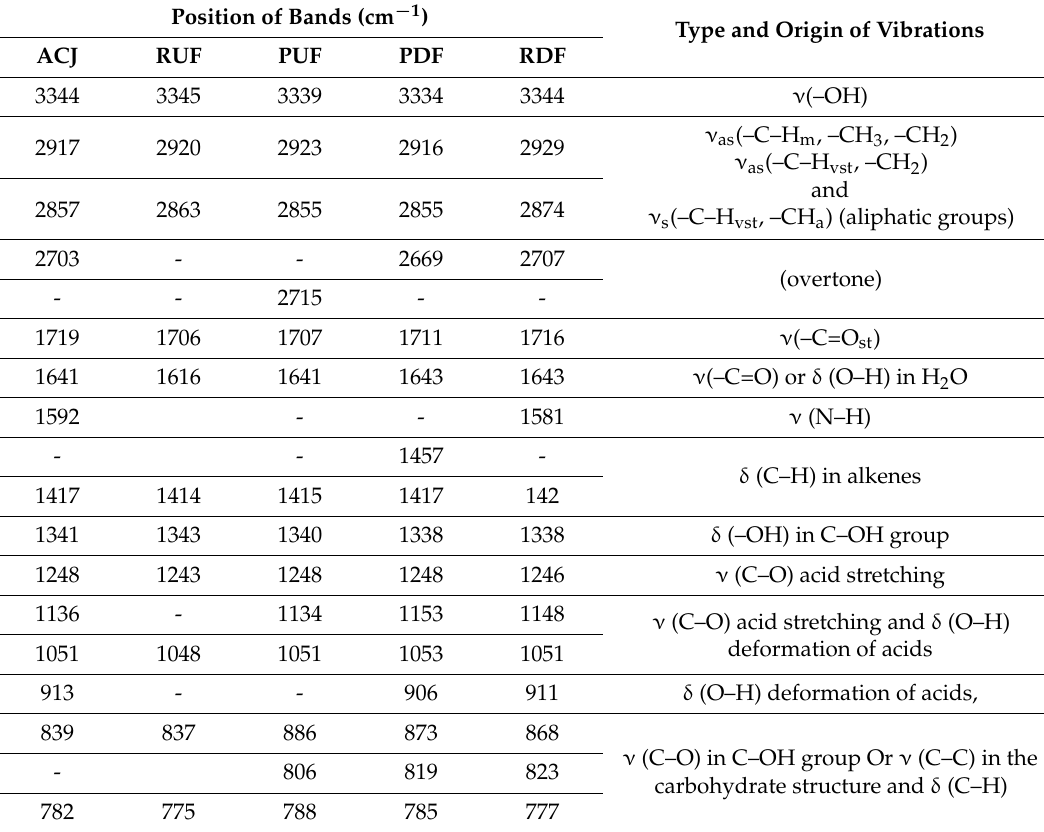
Figure 3. Infrared spectra of the analysed juice samples: ACJ, PDF, RDF, PUF, and RUF in the spectral range from 700 to 3750 cm − 1 . Table 2. The location of the maxima of absorption bands FTIR with arrangement of appropriate vibration in terms of spectral 3750–700 cm − 1 .